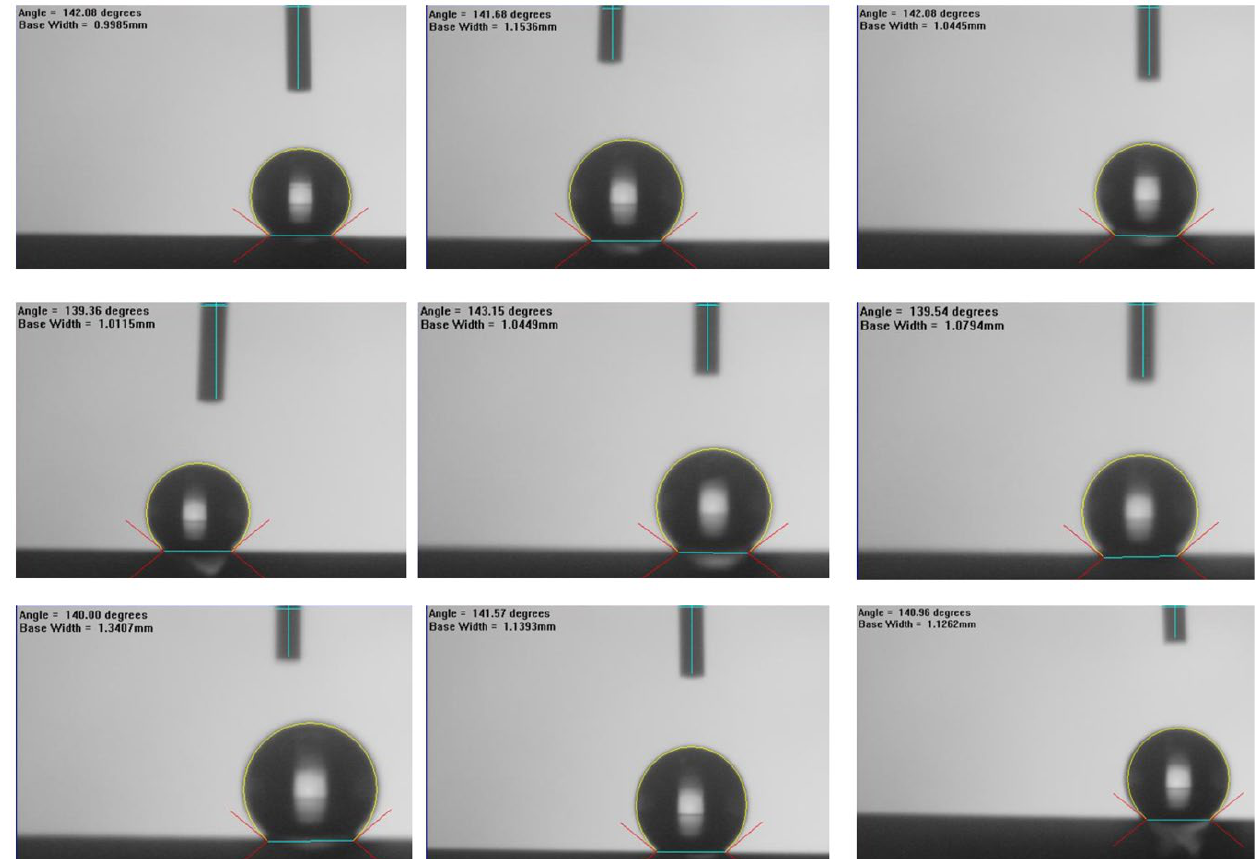
Figure 8. Water contact angles of the fabricated ceramic hollow-fiber membranes.